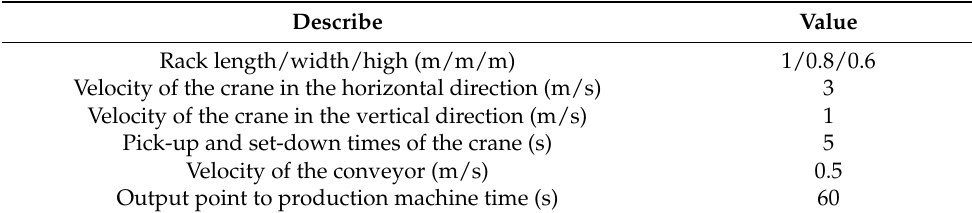
Table 2. Each index parameter of the AS/RS.